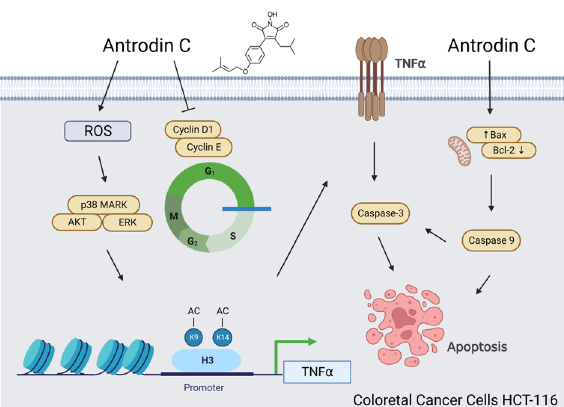
Figure 8. Schematic presentation of the molecular mechanism of antrodin-C-mediated apoptotic induction of colorectal cancer (CRC) cells. Antrodin C treatment increases the expression of death receptor tumor necrosis factor (TNF) α through ROS-derived and ERK/AKT/p38 MAPK-signaling- pathway-mediated histone H3K9K14ac (Acetyl Lys9/Lys14). Activation of TNF α by antrodin C trig- gers cell apoptosis through the inhibition of Bcl-2 and activation of Bax, caspase-3, and -9. On the other hand, antrodin C treatment also causes cell-cycle arrest at the G1 phase through the downreg- ulation of cyclin D1/cyclin E in HCT-116 cells.